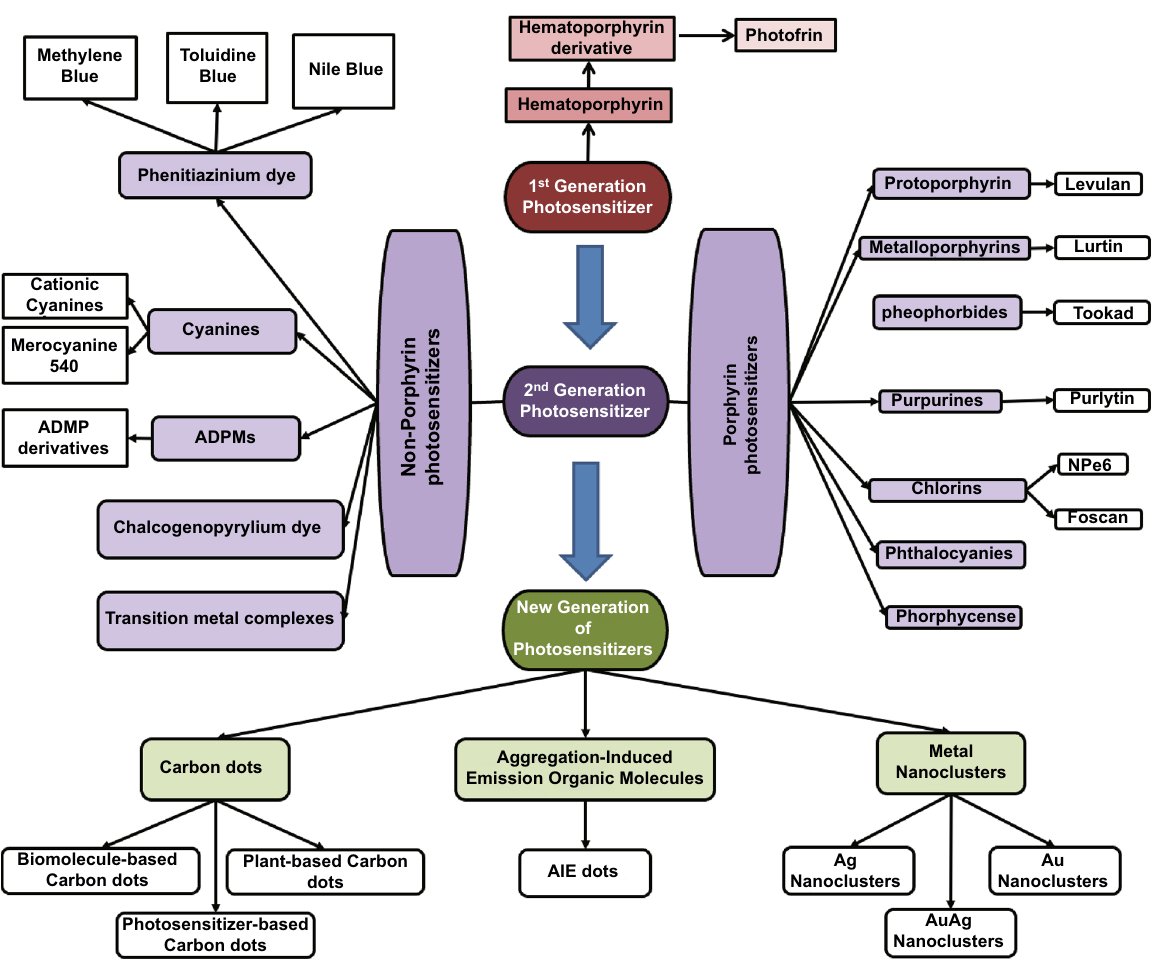
Fig. 2 Classification of different generations of photosensitizers including new generation of nano-photosensitizers that generate singlet oxygen as reviewed in this